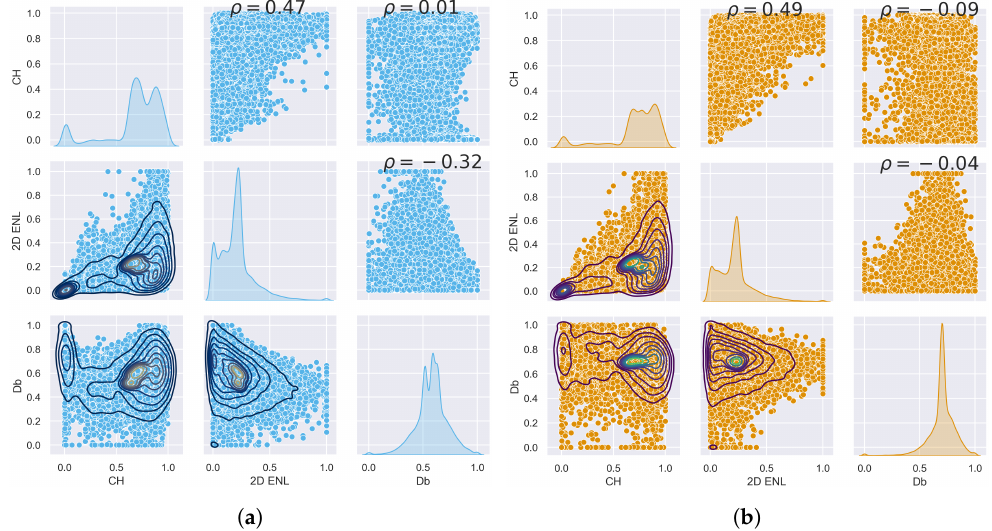
Figure 3. Pair plot comparing CH , 2 D ENL , and D b between each other for ULS (blue) and TLS (orange). ( a ) Selection of ULS traits. ( b ) Selection of TLS